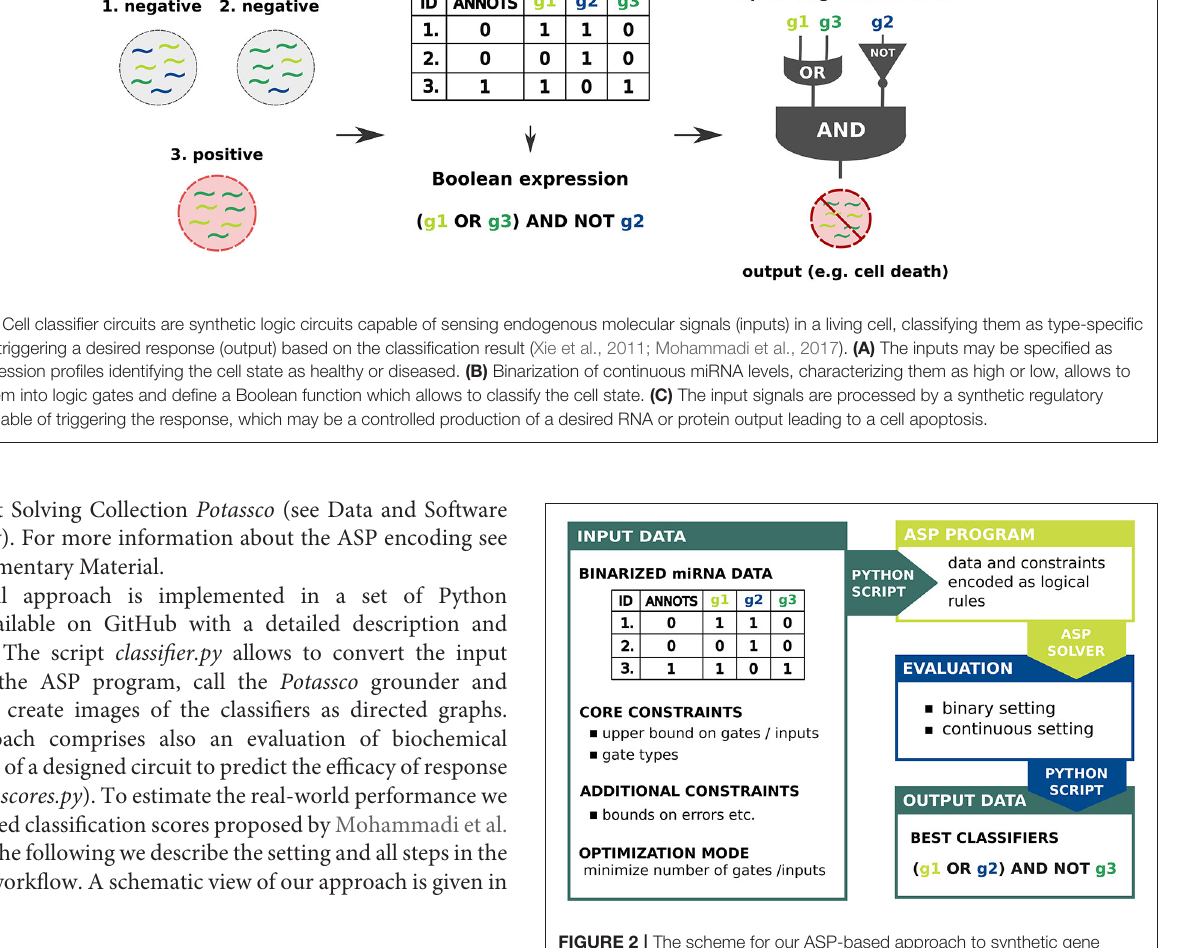
FIGURE 2 | The scheme for our ASP-based approach to synthetic gene circuit